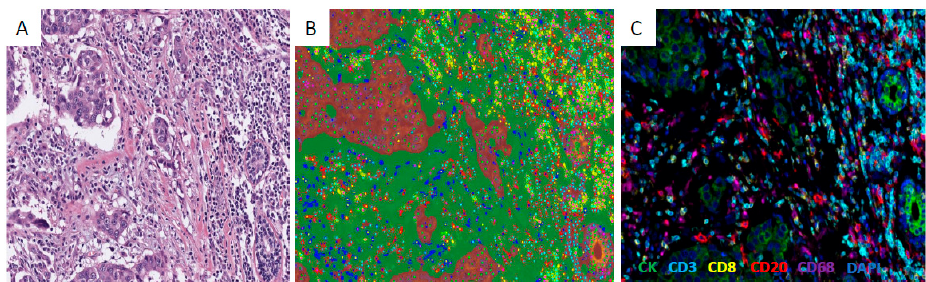
Figure 2. ( A ) Invasive ductal carcinoma with stromal tumour-infiltrating lymphocytes (TILs). (H / E × 200); ( B ) tumour epithelium and stromal segmentation ( × 200); ( C ) multiplexed immunofluorescence ( ×